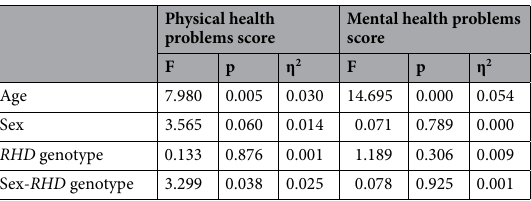
Table 1. Effects of RHD genotype on physical and mental health measured with